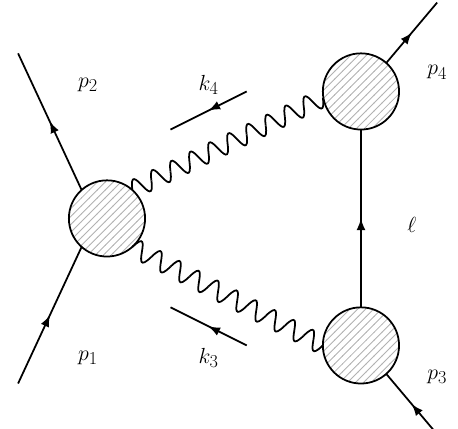
Figure 3. Triangle leading-singularity